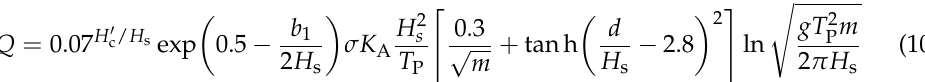
reduction coefficient of angle influence overtopping, as shown in Table 3.